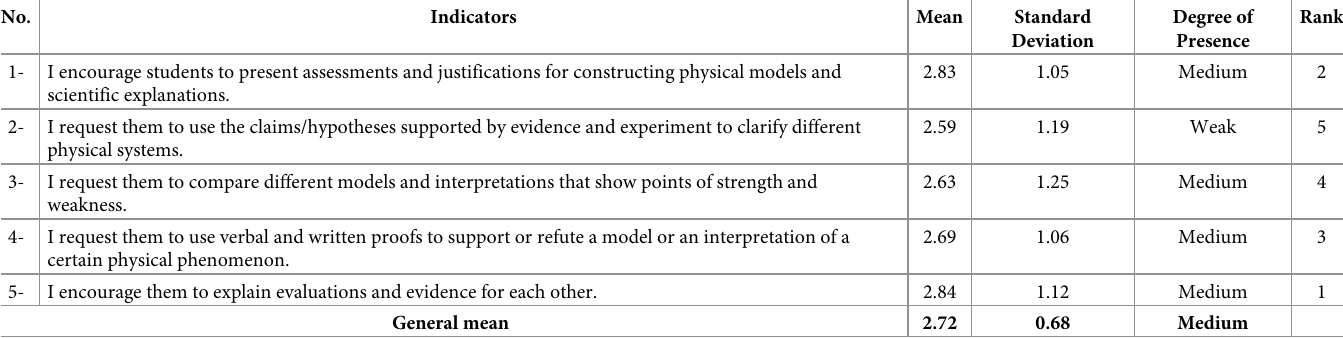
Table 8. The means and standard deviations of the presence of the “involvement with proofs and evidence” practice. No.